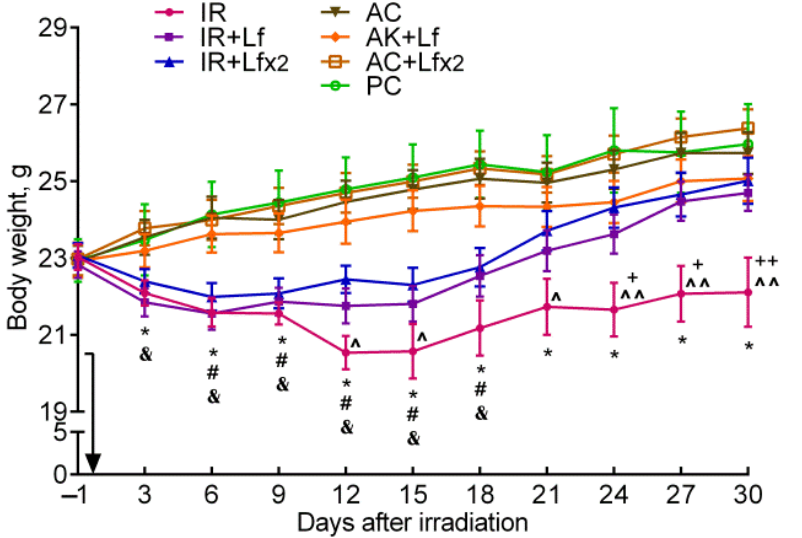
Figure 3. Effect of Lf on the body weight of mice after 7.5 Gy whole-body gamma irradiation. The arrow shows the day of irradiation. Lf (i.p.; 4 mg/mouse) was administered immediately after irradiation/sham-irradiation (IR+Lf, IR+Lf × 2, AC+Lf, AC+Lf × 2) and 24 h after it (IR+Lf × 2, AC+Lf × 2). n = 32 (for IR, IR+Lf, and IR+Lf × 2); n = 17 (for AC, AC+Lf, and AC+Lf × 2); n = 10 (PC). Values are presented as mean ± SEM. * p < 0.05—IR vs. AC; # p < 0.05—IR+Lf vs. AC+Lf; & p < 0.05—IR+Lf × 2 vs. AC+Lf × 2; + p < 0.05, ++ p < 0.01—IR vs. IR+Lf; ˆ p < 0.05, ˆˆ p < 0.01—IR vs. IR+Lf × 2 on the same day.